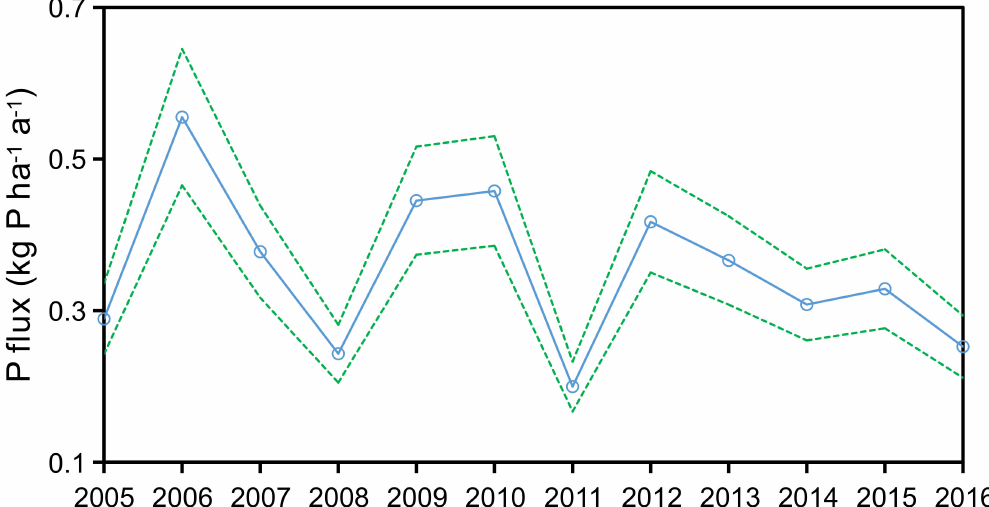
Figure 4. Annual P flux exported from Zhaoshandu Reservoir during 2005–2016. Dotted lines denote the 95% confidence interval obtained from Monte Carlo